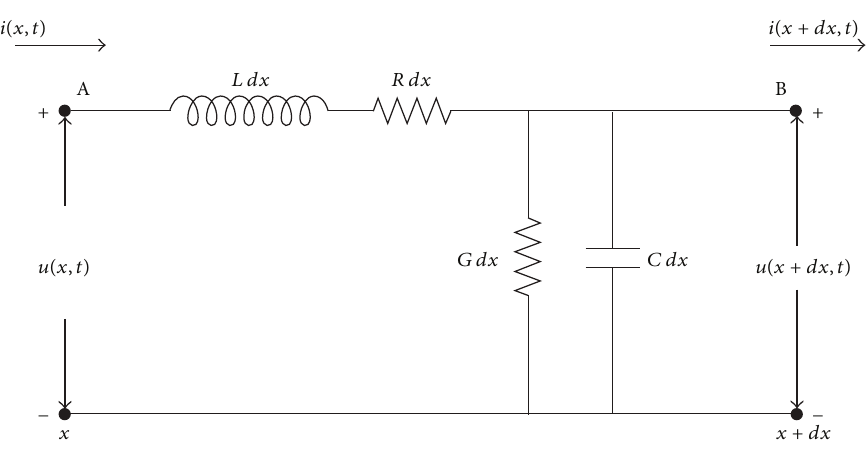
Figure 1: Schematic diagram of telegraphic transmission line with